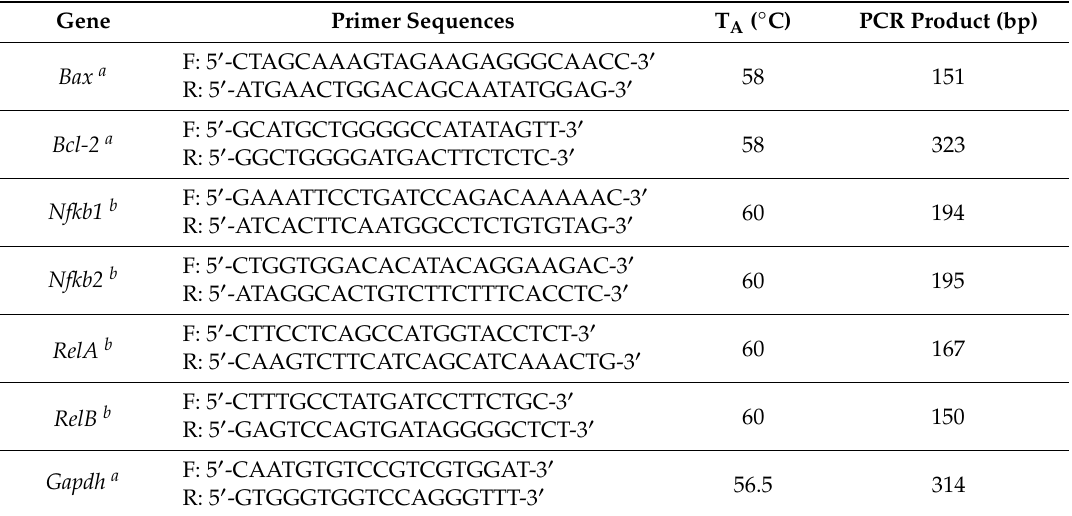
Table 2. PCR primer